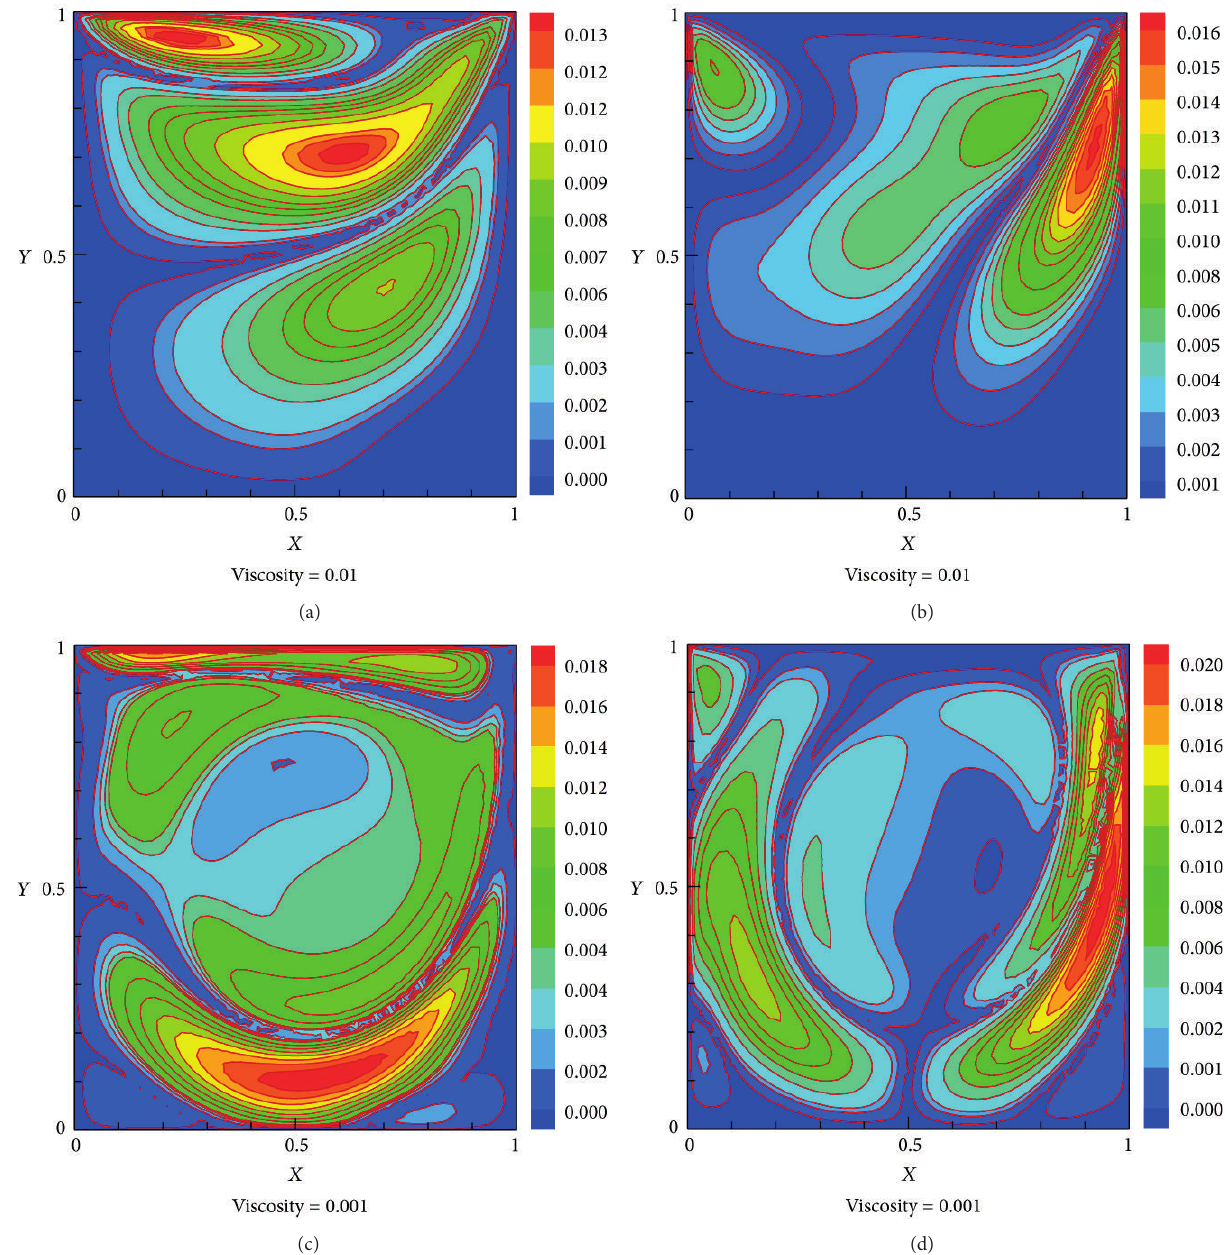
Figure 11: Standard deviation of horizontal ((a) and (c)) and vertical ((b) and (d)) velocity components for 𝑃 = 2 and 𝑀 = 2 .